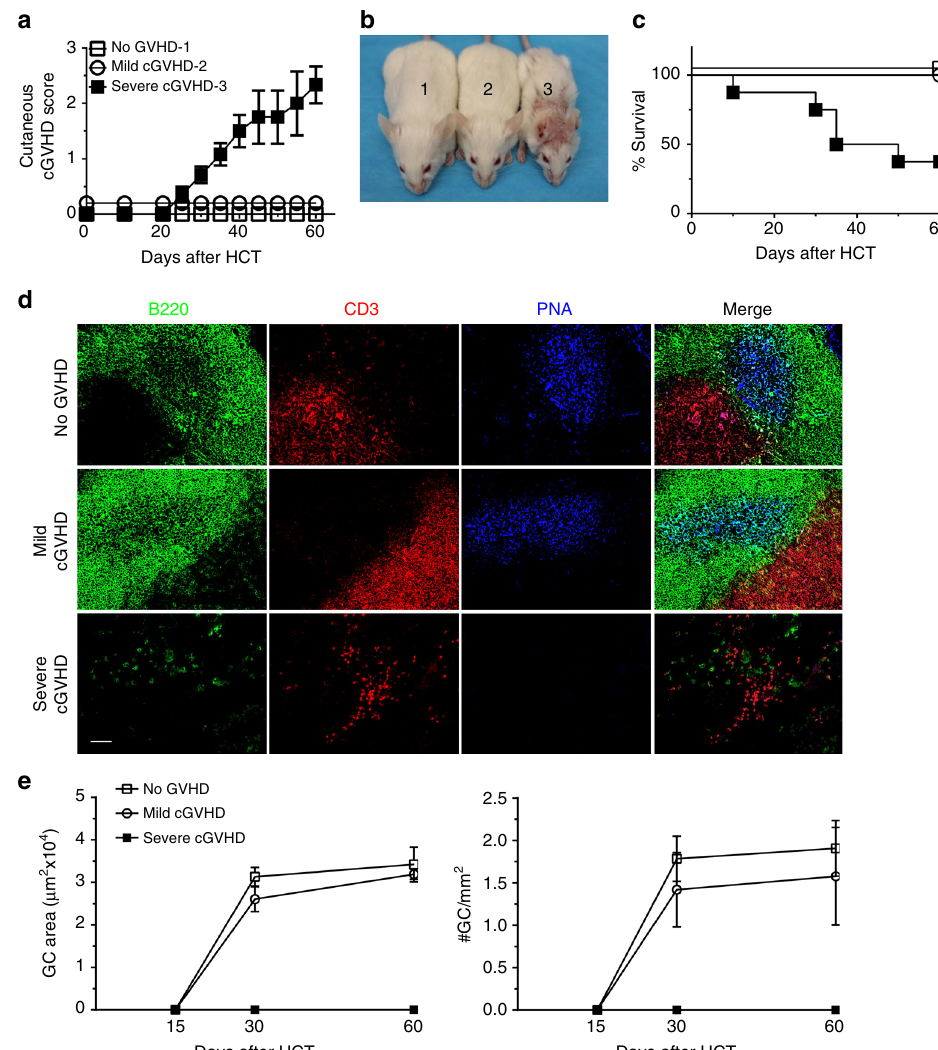
Fig. 1 No germinal center formation is observed in cGVHD recipients. BALB/c mice were irradiated (850 cGy) and given 2.5 × 10 6 TCD-BM alone ( n = 6) or 2.5 × 10 6 TCD-BM plus 1 × 10 6 ( n = 8) or 0.01 × 10 6 ( n = 8) splenocytes from C57BL/6 donors. Mice were monitored for cGVHD. a Cutaneous cGVHD score (severe cGVHD group versus no-GVHD group: P < 0.001, severe cGVHD group versus mild cGVHD group: P < 0.001, two-way ANOVA). b Picture taken on day 60 after transplantation (1 – no GVHD, 2 – mild cGVHD, 3 – severe cGVHD). c Survival curve (severe cGVHD group versus no GVHD group: P < 0.001, severe cGVHD group versus mild cGVHD group: P < 0.001, log-rank test). d Immuno fl uorescent staining of B220, CD3, and PNA